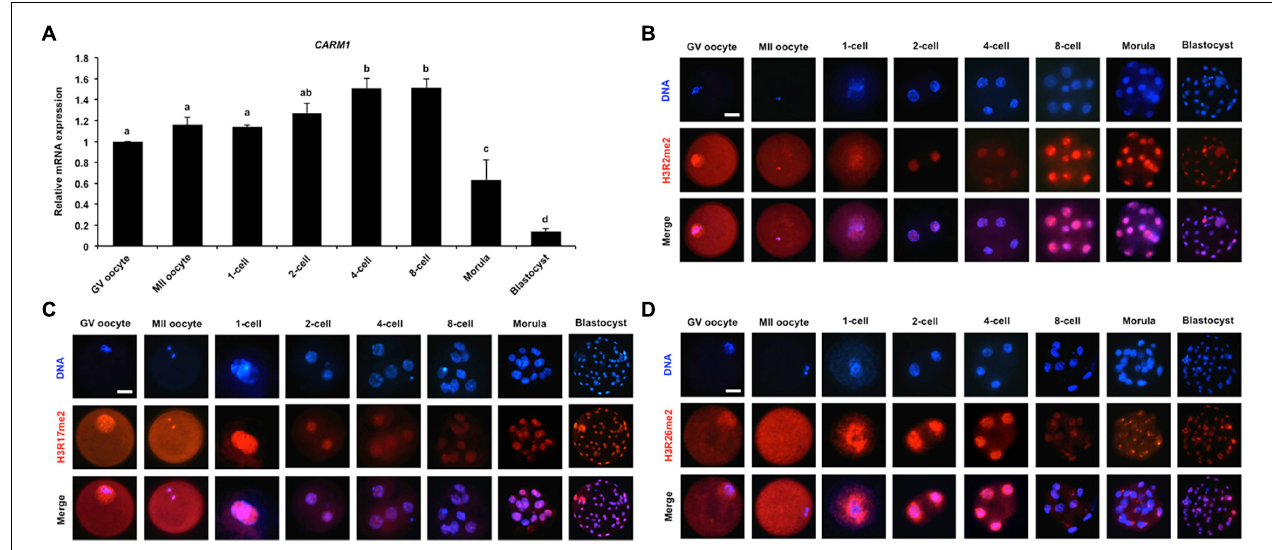
FIGURE 1 | Dynamics of CARM1 mRNA and putative histone substrates in early embryos. (A) Expression of CARM1 mRNA in porcine early embryos. Relative abundance of CARM1 mRNA was determined by qPCR. Data were normalized to the reference gene ( EF1 α 1 ) and the data from GV oocytes were set as 1. GV, germinal vesicle; MII, metaphase II. Data are shown as mean ± S.E.M and different letters on the bars indicate significant differences ( P < 0.05). Changes of H3R2me2 (B) , H3R17me2 (C) , H3R26me2 (D) levels in early embryonic development. Embryos were stained for H3R2me2, H3R17me2, H3R26me2 (red), and DNA (blue). Representative images obtained by confocal microscopy are shown. The experiment was independently repeated three times with at least 30 embryos per group. Scale bar: 50 µ